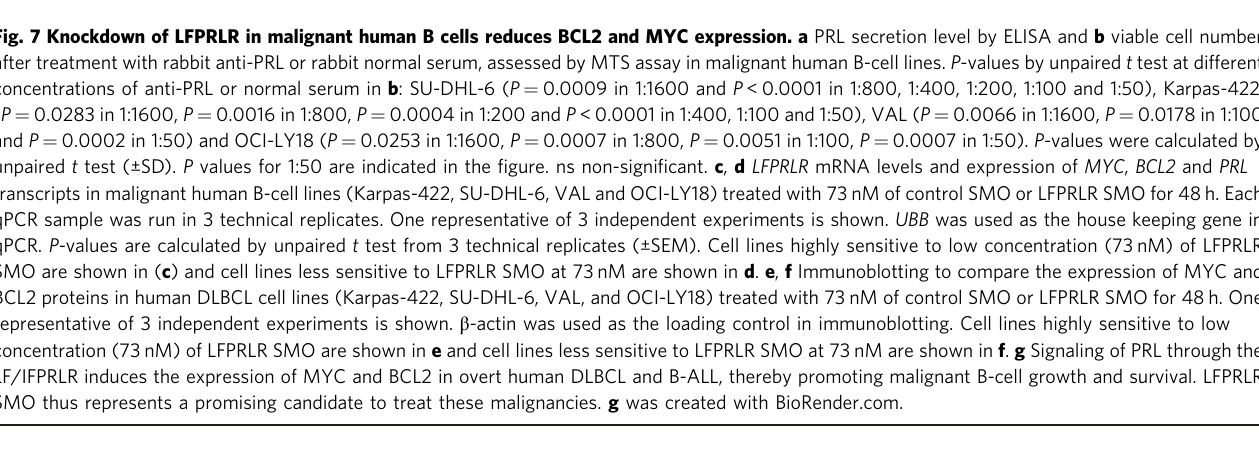
Table 1c), as described previously 72,73 . Selective ampli fi cation of the J558 variable region of the IGH (V H ) family was conducted due to the increased representation of this family in both the production of autoantibodies and non-binding antibodies in MRL-lpr SLE-prone mice 74 . Amplicons were subjected to next generation